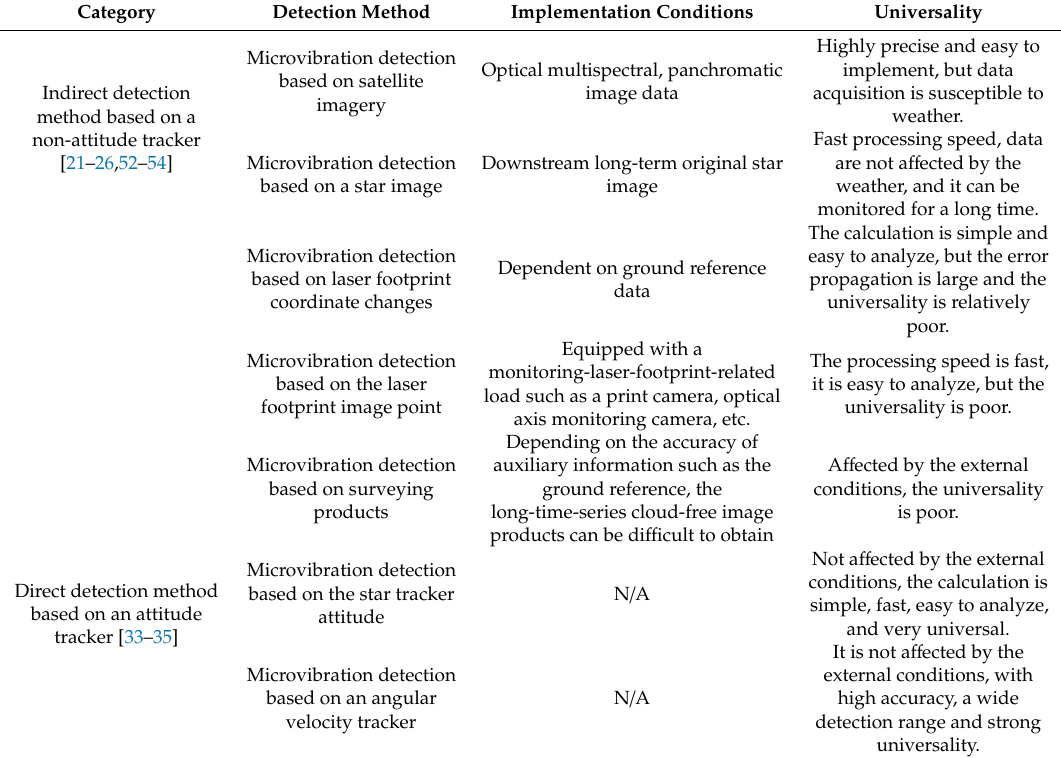
Table 4. Comparison of